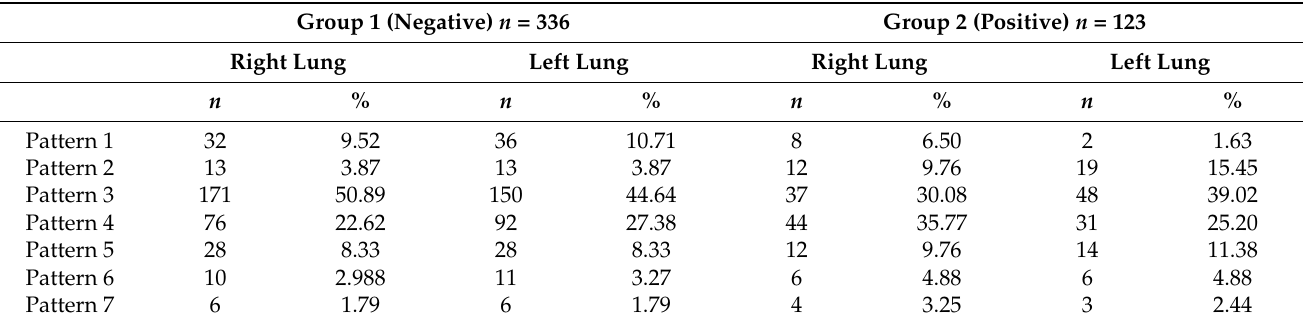
Table A1. Pattern distribution and classification in right and left